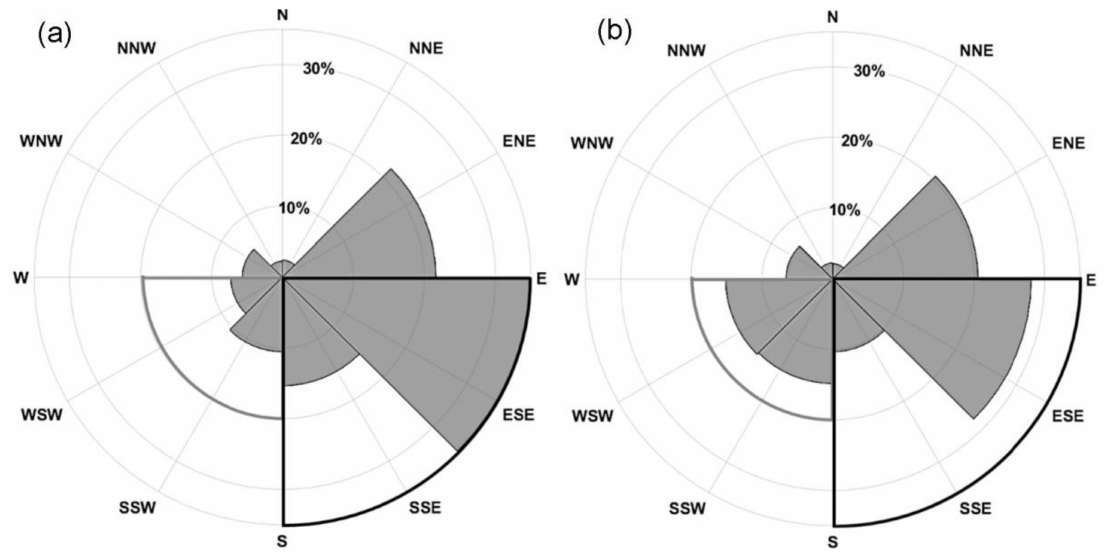
Figure 9. The percent of trajectories that fell in 8 radial sections around DENA-HQ. Rolling seven-day back trajectories were calculated using the Hybrid Single Particle Lagrangian Integrated model (HYSPLIT) model. Trajectories were calculated seven days before and after the date of the annual 4th-highest DM8HA at DENA-HQ for the periods 1987–1998 ( a ) and 1999–2015 ( b ). The grey boxes indicate the area where an increase in trajectories were seen from period one ( a ) to period two ( b ) and the black box indicates where a decrease in trajectories were seen from period one ( a ) to period two ( b